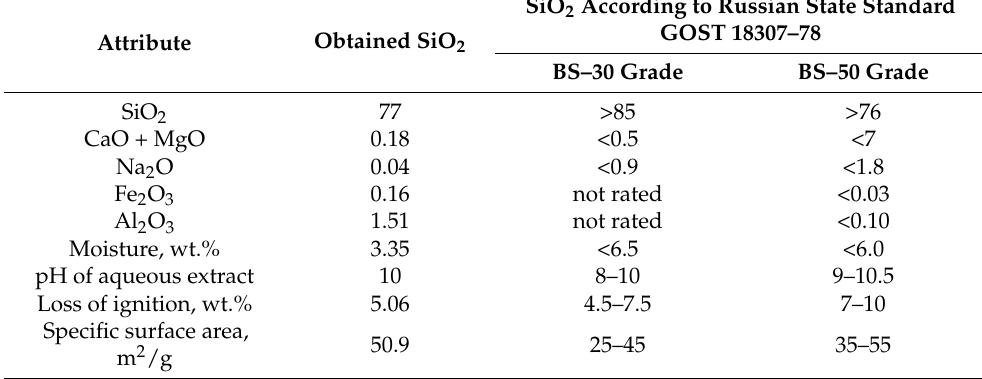
Table 9. Comparison with standard requirements of SiO 2 obtained by precipitation from silicate solution followed by water washing and drying at 250 ◦ C,